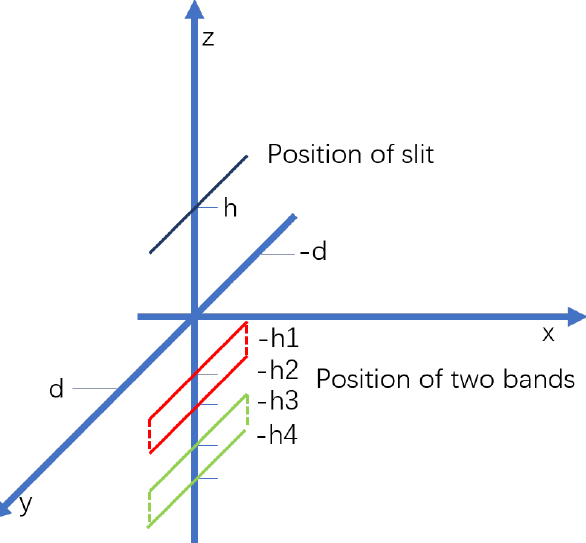
Figure 5. The position of the slit and the two spectra.